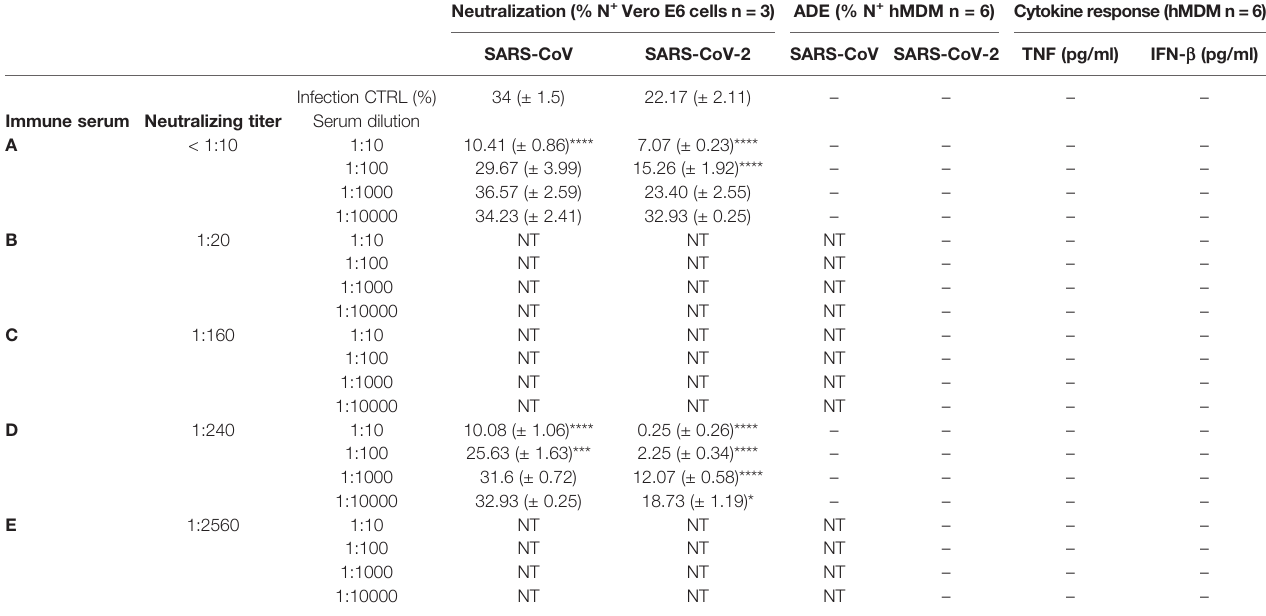
TABLE 2 | Summary data for virus neutralization on Vero E6 cells and antibody-dependent enhancement of infection or cytokine response by hMDM for SARS-CoV and SARS-CoV-2-antibody complexes ” + ” detected; “ - ” not detected; “ NT ” not